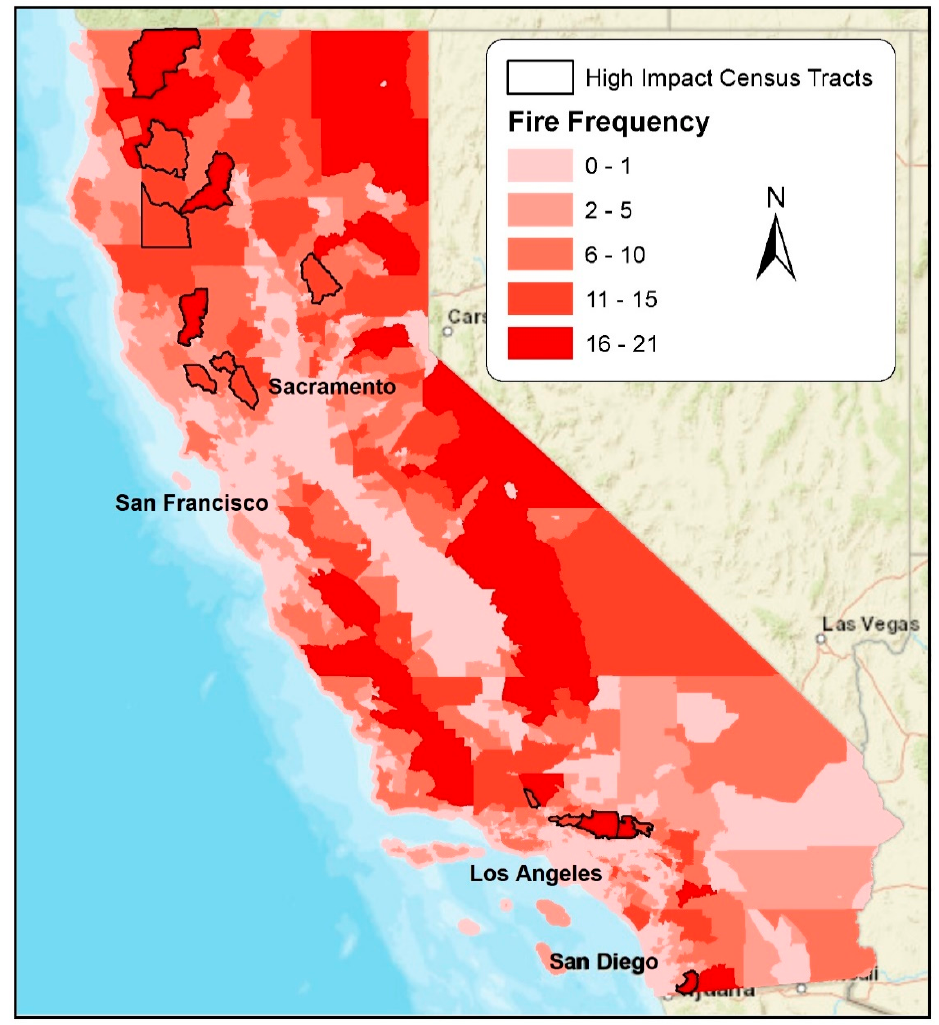
Figure 6. Number of years a Census tract experienced wildfire (fire frequency), along with 15 “highly impacted” Census tracts as defined by fire frequency and percent burning.